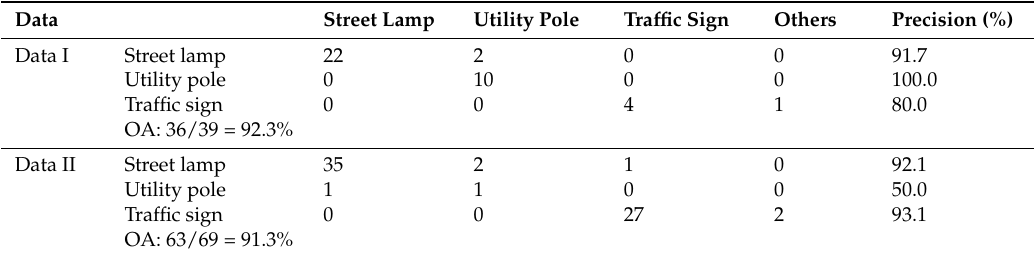
Table 5. Quality of classification results of